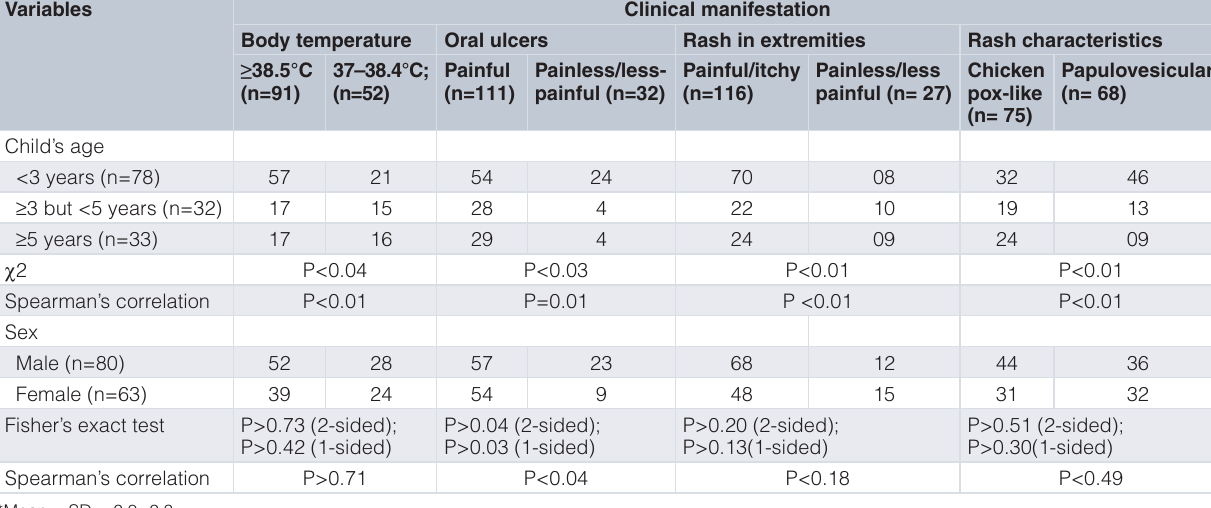
Table 2. Composite table showing association of HFMD clinical features with age and